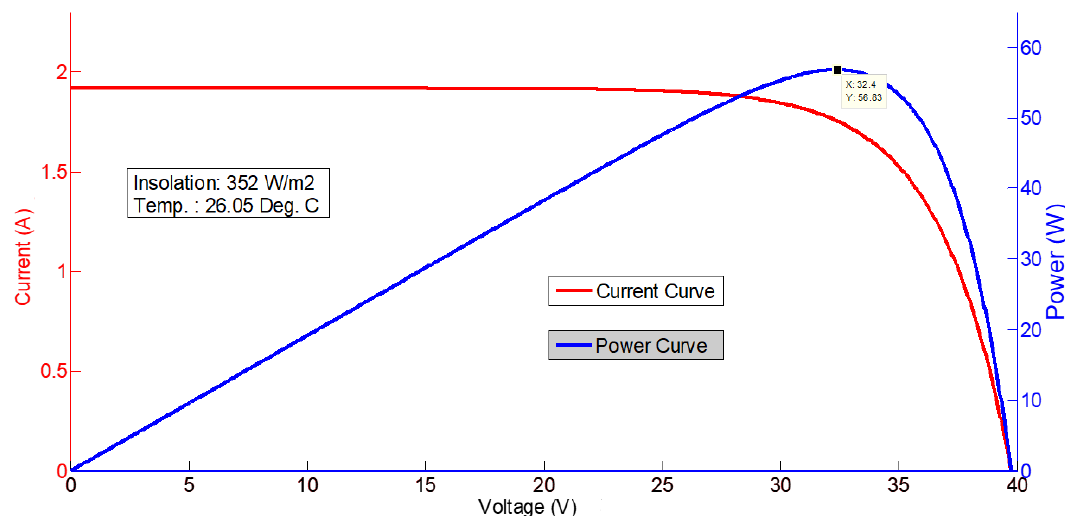
Figure 12. I-V and P-V characteristic of PV array at 09:00 A.M.